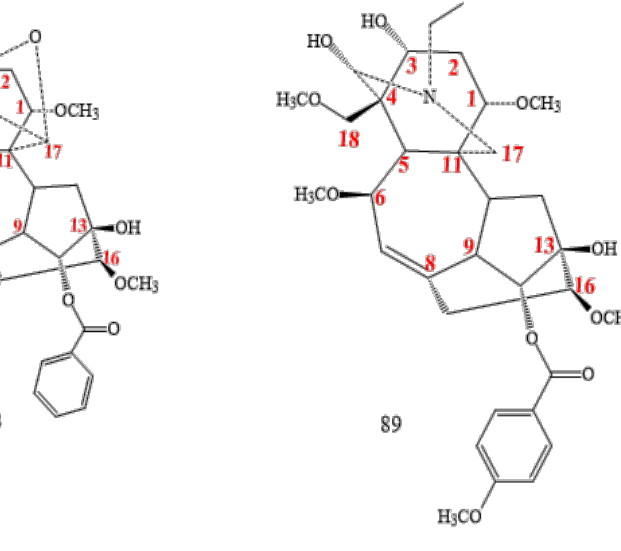
Figure 8. C 19 7,17-Seco DAs.